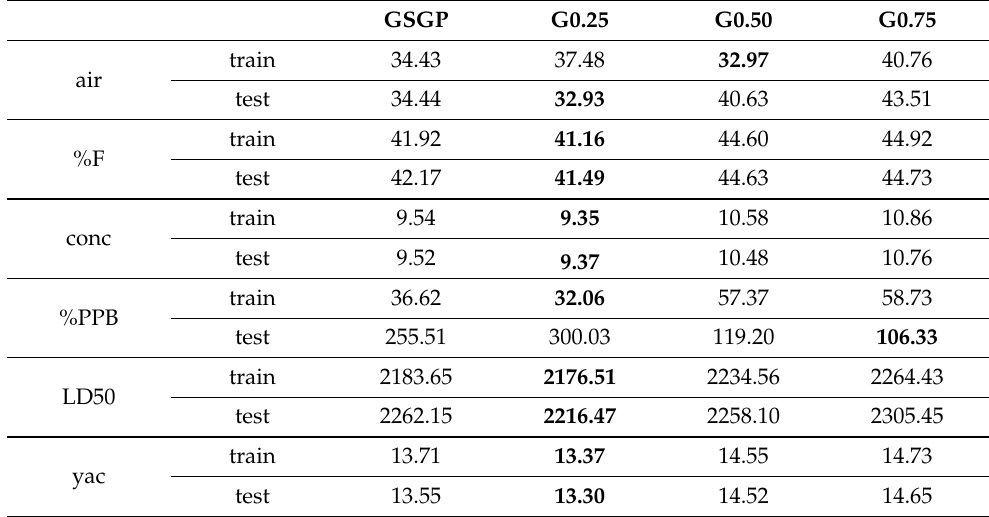
Table 4. Fitness values obtained by selecting the ancestors with geometric multi-generational selection. The values in bold are the best results obtained.